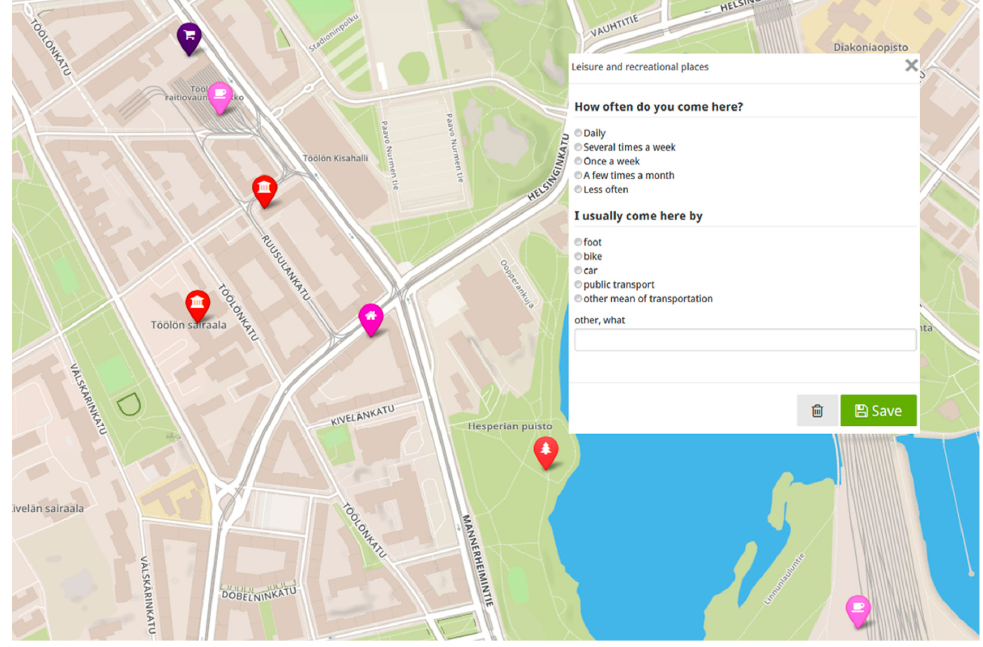
Figure 1. The online interface of the survey.